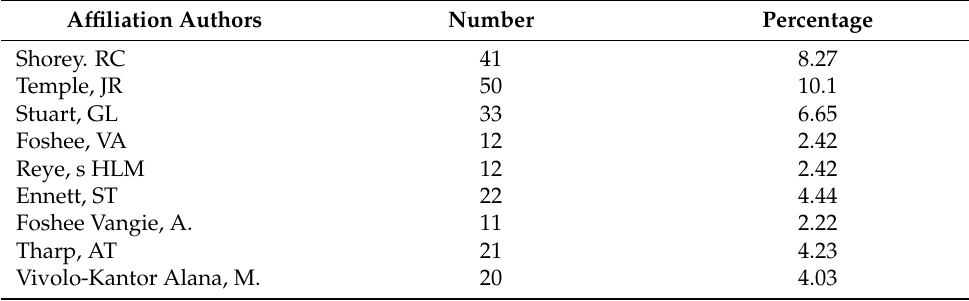
Table 7. Authors with the highest scientific production in the WoS database.